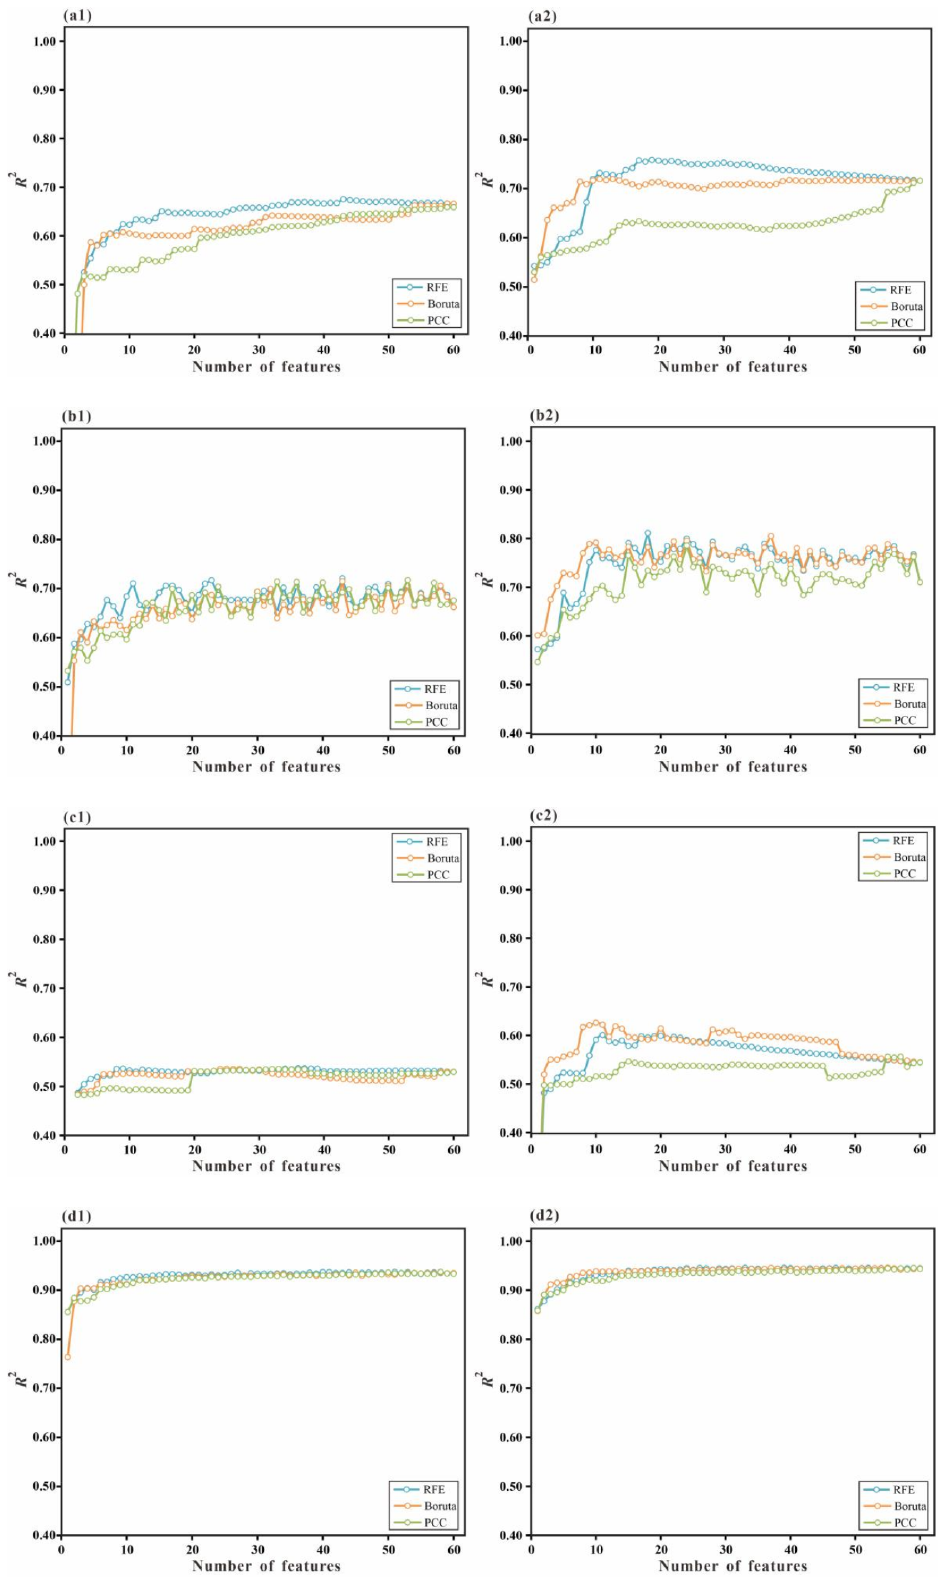
Figure 5. The relationships between model training accuracy and number of features. ( a1 , a2 ), SVM model at the flowering and grain-filling stages, respectively; ( b1 , b2 ), GP model at flowering and grain-filling stages, respectively; ( c1 , c2 ) LRR model at flowering and grain-filling stages, respectively; ( d1 , d2 ) RF model at flowering and grain-filling stages,